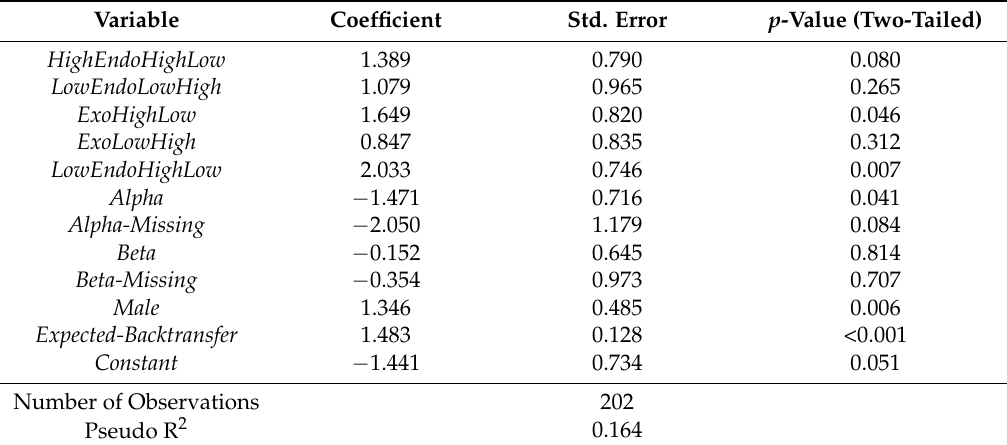
Table 6. Tobit Regression of Investment (data for asymmetric endowments only; reference treatment is HighEndoLowHigh